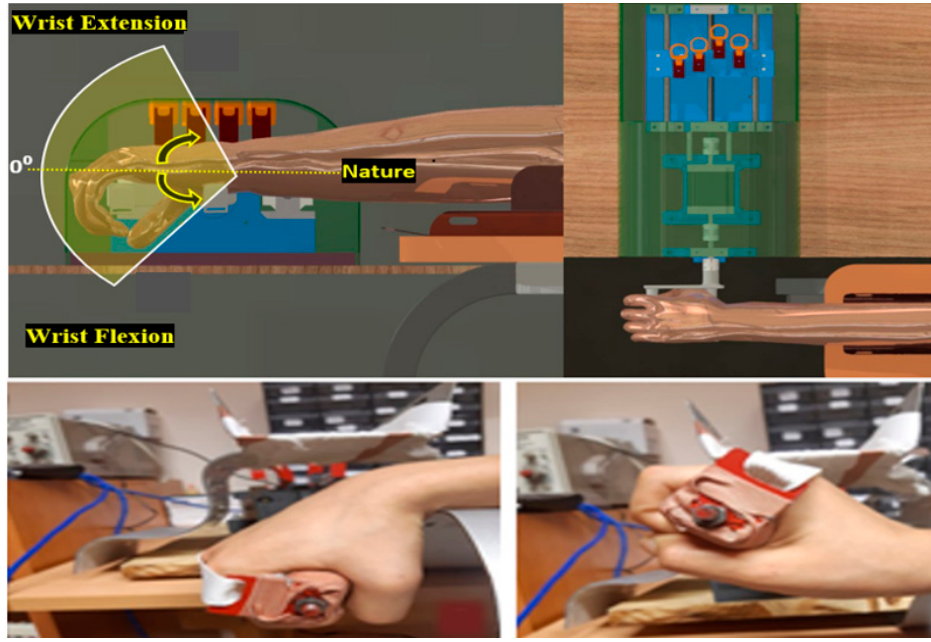
Figure 4. 3D model structure and health object integration with the proposed wrist flexion/extension (F/E) attachment mechanism.